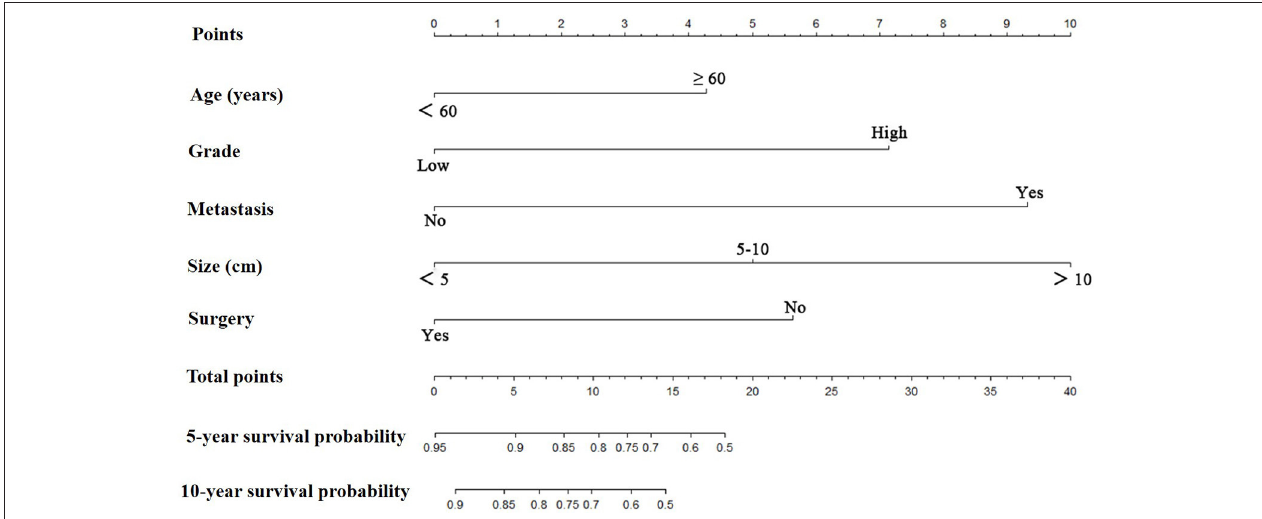
FIGURE 2 | The graph shows the nomogram predicting 5- and 10-year cancer-specific survival of patients with extremity leiomyosarcoma. The nomogram summed the points identified on the scale for each predictor. The total points projected on the bottom scales indicate the probabilities of 5- and 10-year cancer-specific survival.